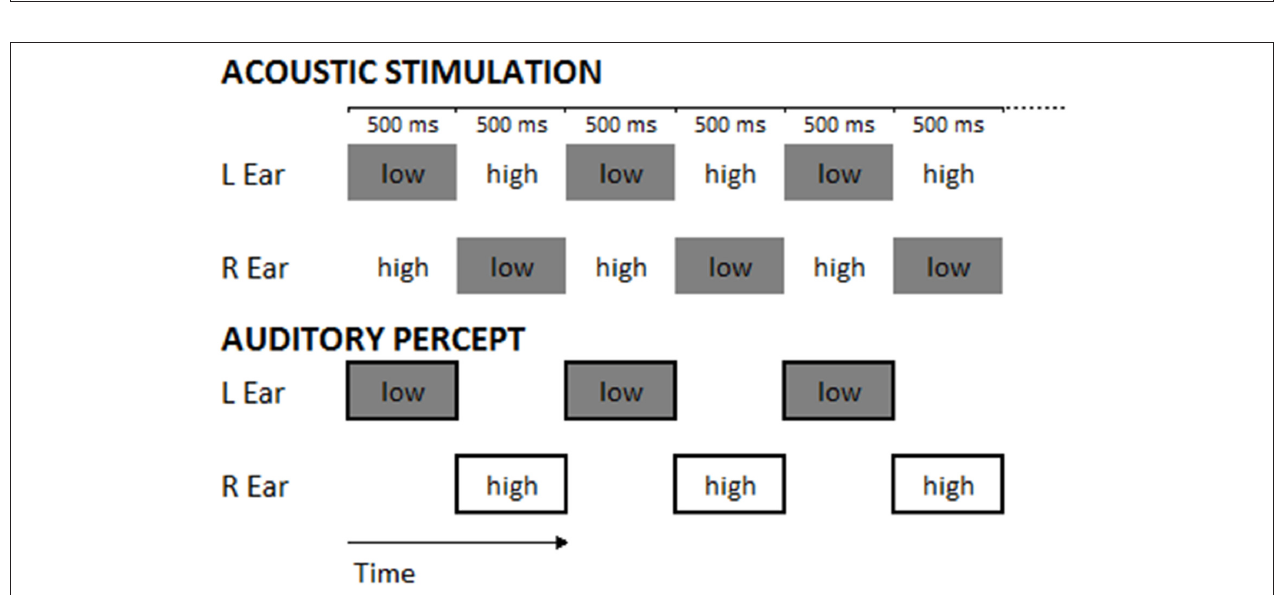
FIGURE 1 | Experimental procedure of Experiment 1: tDCS (A) , and Experiment 2: tRNS (B) . Participants completed three sessions in Experiment 1 (Left stimulation, Right stimulation, Sham), and two sessions in Experiment 2 (tRNS, Sham). Each session lasted 20 min: after 5 or 15 min from the beginning of stimulation, participants performed the task. Order of sessions and interval of stimulation before the task were balanced among participants.